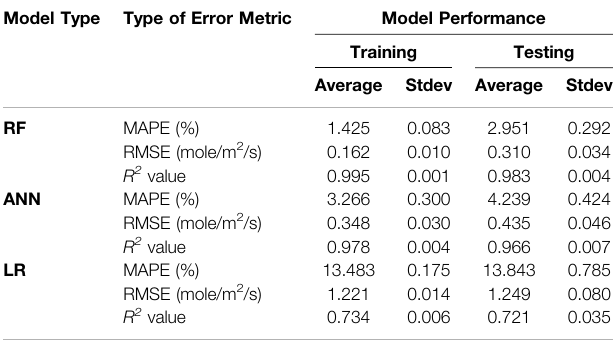
TABLE 3 | Summary of the error metrics for the RF, ANN and LR models on the prediction of quartz dissolution rates. The values are averaged based on twenty independently trained models (each with a different training-testing split by usingadifferentrandomstate)withonestandarddeviation(Stdev)alsogiveninthe table. The error metrics for training are calculated based on all the 85% of the data used for training the model, i.e., including the training and validation folds usedduringthe fi ve-foldcross-validationprocess. Detailsonthecalculationof the error metrics are given in Supplementary Material B